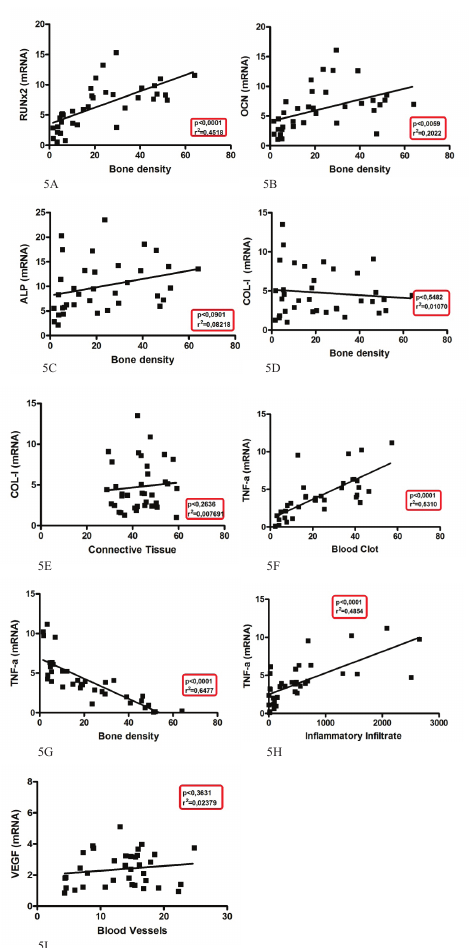
FIGuRE 5 – Correlations between microscopically and molecularly variables examined were investigated by linear regression